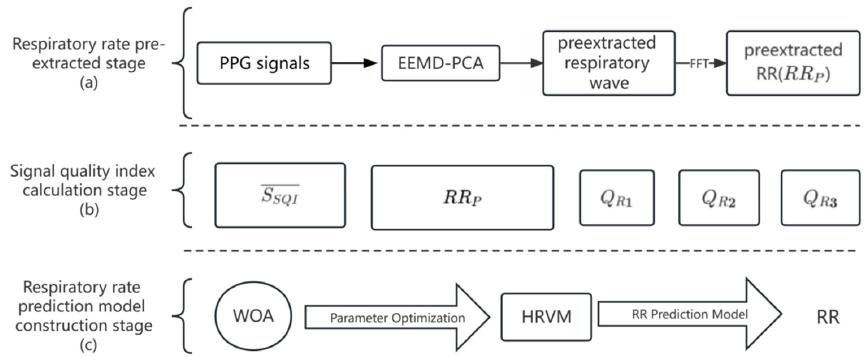
Figure 1. Flow chart of respiration rate prediction model construction .